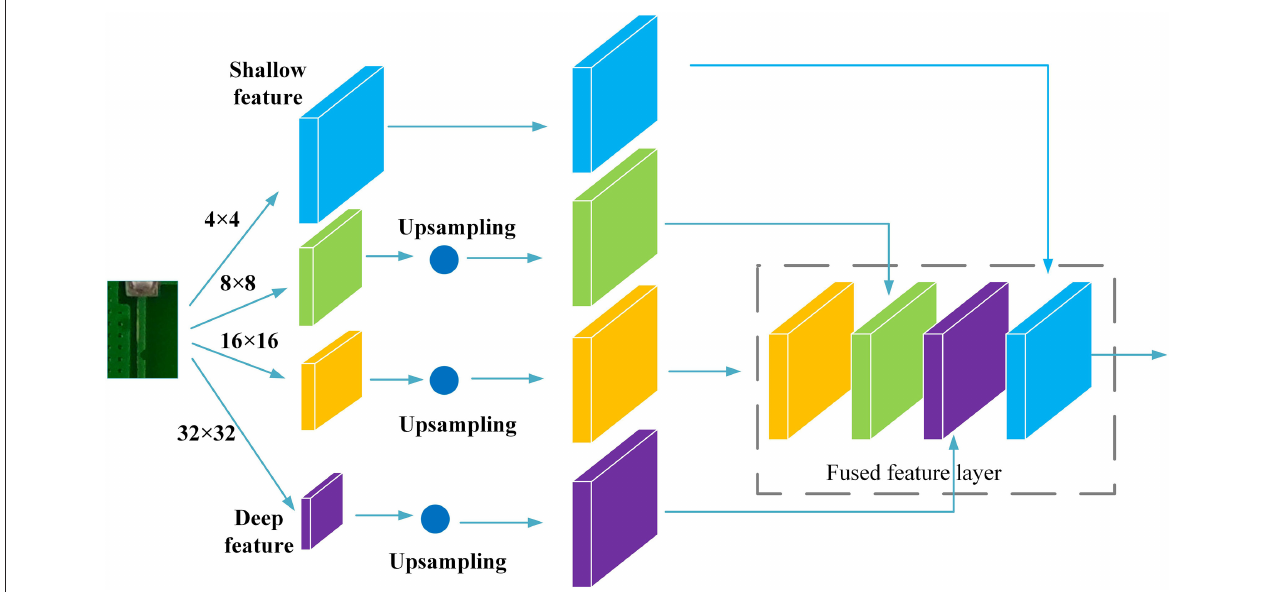
FIGURE 5 | The structure of the parallel high-definition feature extraction method.